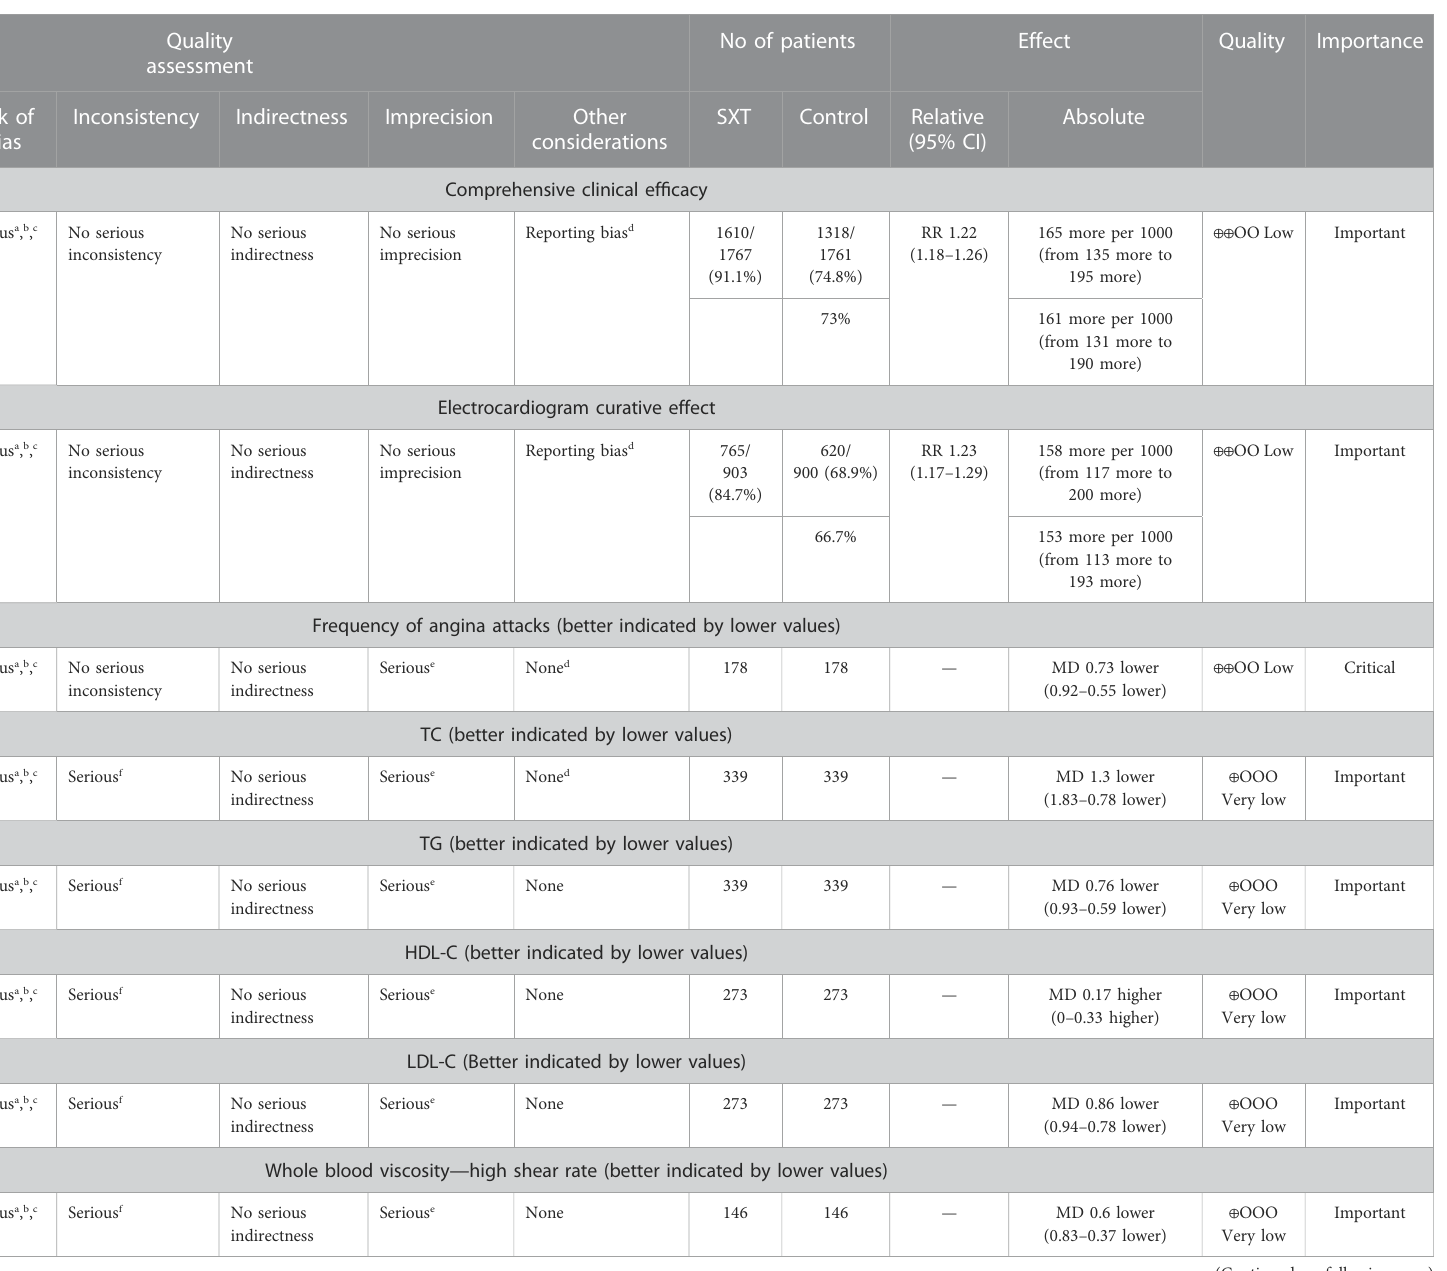
TABLE 2 GRADE evidence pro fi